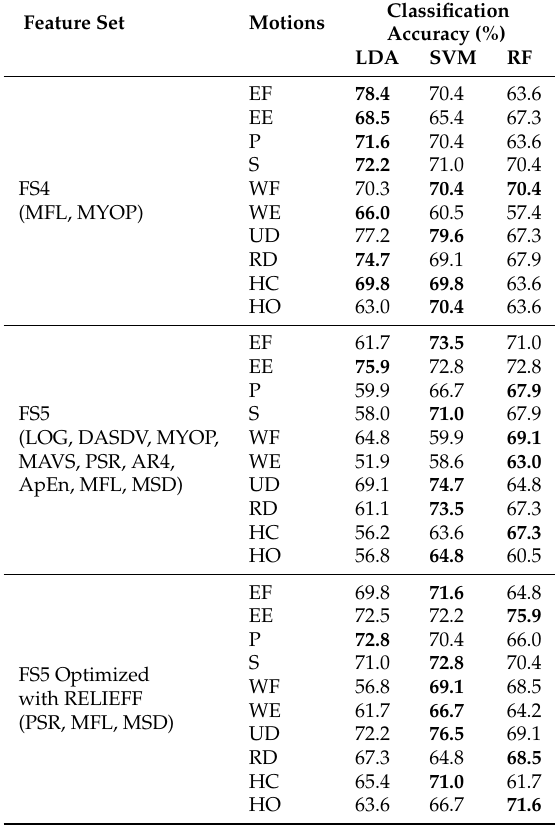
Table 5. Classification accuracies for each feature set. The best classification result for each motion within each feature set is in